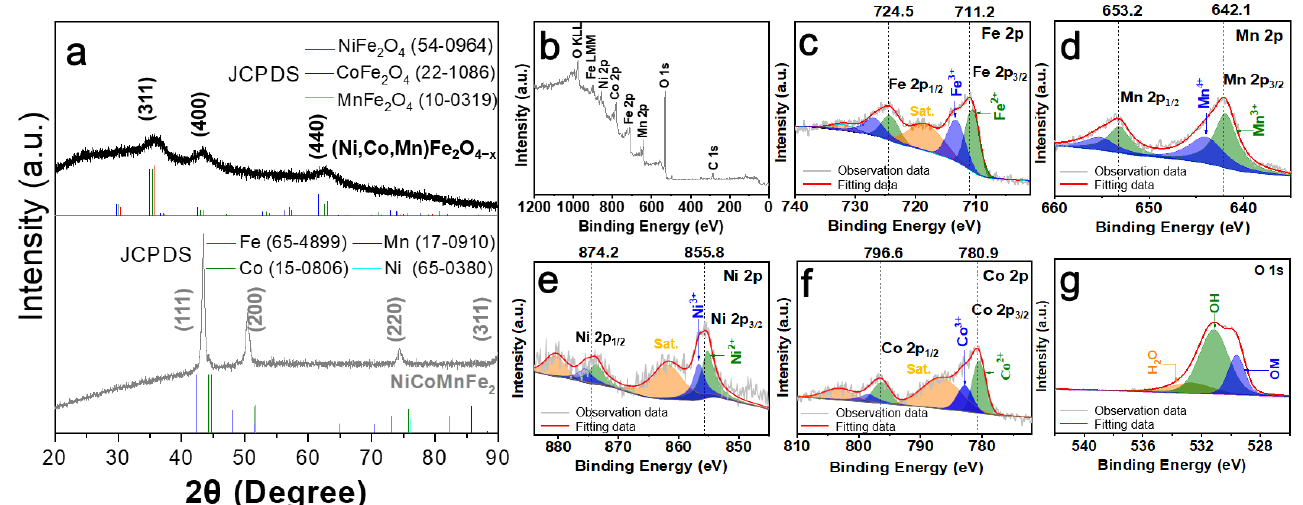
Figure 3. ( a ) XRD patterns of pristine NiCoMnFe 2 and dealloyed (Ni,Co,Mn)Fe 2 O 4 − x oxides. ( b – g ) XPS spectra of (Ni,Co,Mn)Fe 2 O 4 − x : ( b ) XPS survey spectra; ( c – g ) high-resolution core-level spectra of Fe 2p, Mn 2p, Ni 2p, Co 2p and O 1s, respectively.